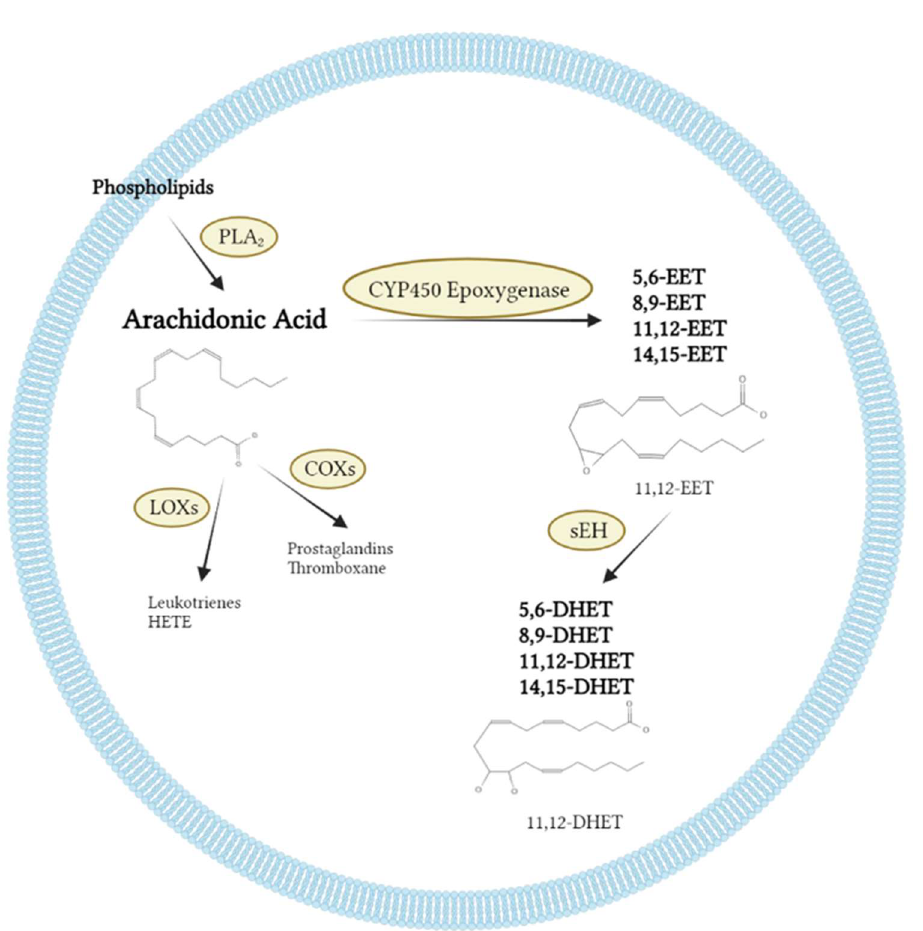
Figure 1. Schematic figure of arachidonic acid metabolism. Membrane phospholipids are converted to AA by PLA 2 . The COXs metabolize AA to PGs and TXAs. The LOXs metabolize AA to LTs and HETEs. The CYP450 (including the 2J and 2C families) metabolize AA to four regioisomers of EETs, 5,6-EET, 8,9-EET, 11,12-EET and 14,15-EET, respectively; the EETs are hydrolyzed by the sEH to DHETs with very low biological activity. (AA, arachidonic acids; EETs, epoxyeicosatrienoic acids; COXs, cyclooxygenases; LOXs, lipoxygenases; CYP450, CYP450epoxygenases; PGs, prostaglandins; TXA2, thromboxane A2; LTs, leukotrienes; sEH, soluble epoxide hydrolase; HETE, hydroxyeicosatetraenoic acids; DHETs, dihydroxyeicosatrienoic acids).